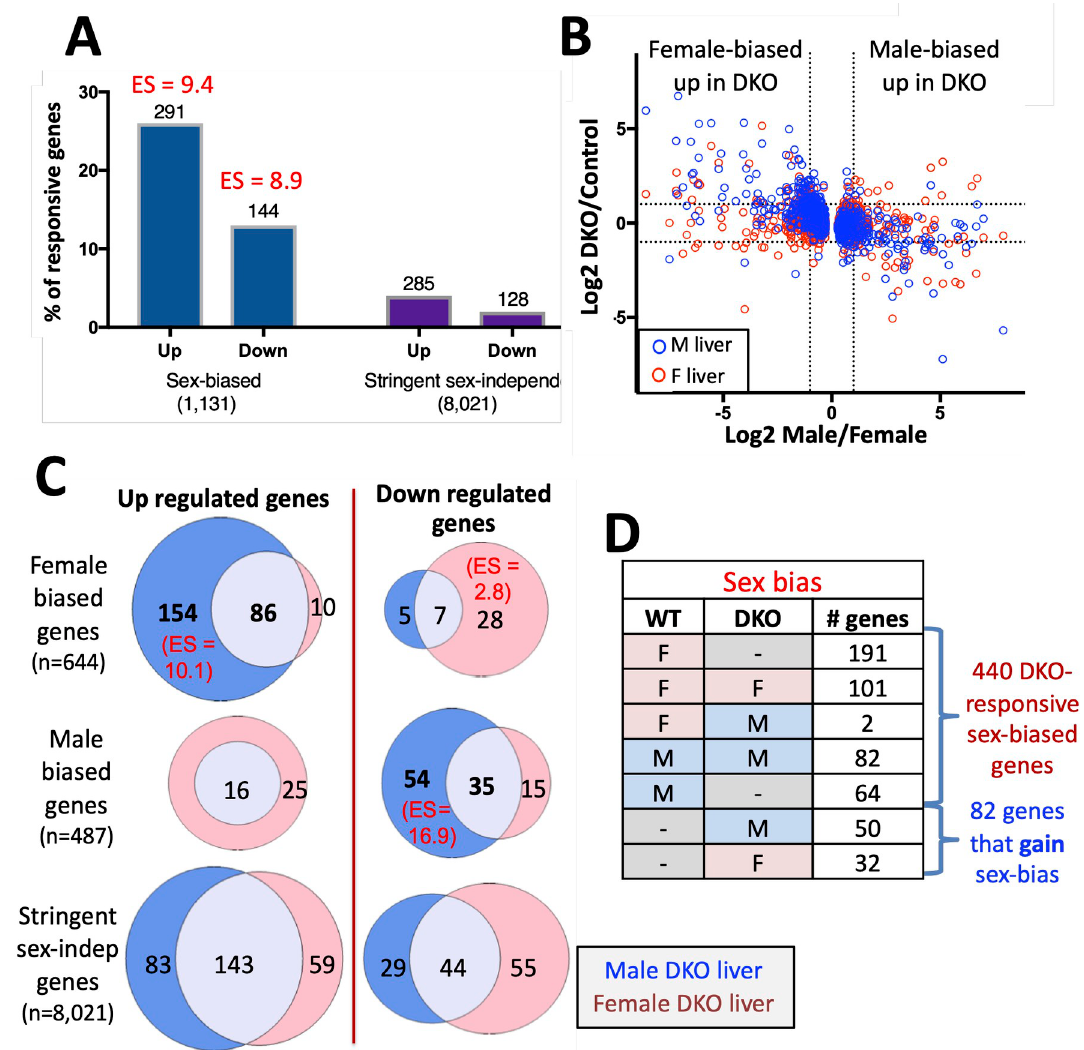
Fig 2. E1/E2-KO de-represses female-biased genes in male liver. ( A ) Percentage of all RefSeq genes that are liver-expressed (FPKM > 1) and either sex-biased (male/female FDR < 0.01; n = 1,131 genes) (S2A Table) or stringently sex-independent (male/female |fold- change| < 1.2 and FDR > 0.1; n = 8,021 genes) (S2C Table) whose expression in E1/E2-KO liver is significantly changed compared to control liver (|fold-change| > 1.5 at FDR < 0.05) (’responsive genes’). The number of sex-biased genes that are up or down-regulated in E1/E2-KO liver and their enrichment (ES, enrichment score) compared to E1/E2-KO-responsive, stringently-sex independent genes is shown above each bar (p < 2.2E-16 for both enrichments). Overall, sex-biased genes comprised 38% of the genes dysregulated in E1/ E2-KO liver (435 of 1,131 sex-biased genes; S3B Table) versus 5.1% of stringently-sex-independent genes (413 of 8,021 genes; S3C Table). ( B ) Log2 expression ratios for E1/E2-KO/control liver vs log2 sex-ratio for 1,131 sex-biased genes, determined in male (blue) and female (red) mouse liver. Dashed lines, significance cutoff values for each comparison. ( C ) Overlap of E1/E2-KO-responsive female-biased genes (and separately, male-biased genes) identified in male liver (blue shading) vs. female liver (pink shading). Overlaps are shown separately for genes that are up-regulated ( left ) and genes that are down-regulated ( right ) in E1/E2-KO liver. Shown at the bottom are the overlaps of stringent sex-independent genes that were E1/E2-KO responsive in male vs. female liver. Significant enrichment scores (ES) compared to a background set of all 11,491 liver-expressed genes (FPKM > 1) are shown in parenthesis. Five genes responded to the loss of Ezh1/Ezh2 in the opposite direction in male vs. female liver and were excluded from these Venn diagrams: 4 female-biased genes up-regulated in male E1/E2-KO and down-regulated in female E1/E2-KO, and 1 male-biased gene up-regulated in female E1/E2-KO and down-regulated in male E1/E2-KO. DKO, Ezh1/Ezh2 double knockout mouse liver. ( D ) Number of E1/E2-KO-responsive genes that lose, maintain, or gain sex specificity in either male or female E1/E2-KO mouse liver. Two genes showed a reversal from female bias to male bias in E1/E2-KO liver. Sex bias is either: M, male; F, female; or not sex-biased (dashed